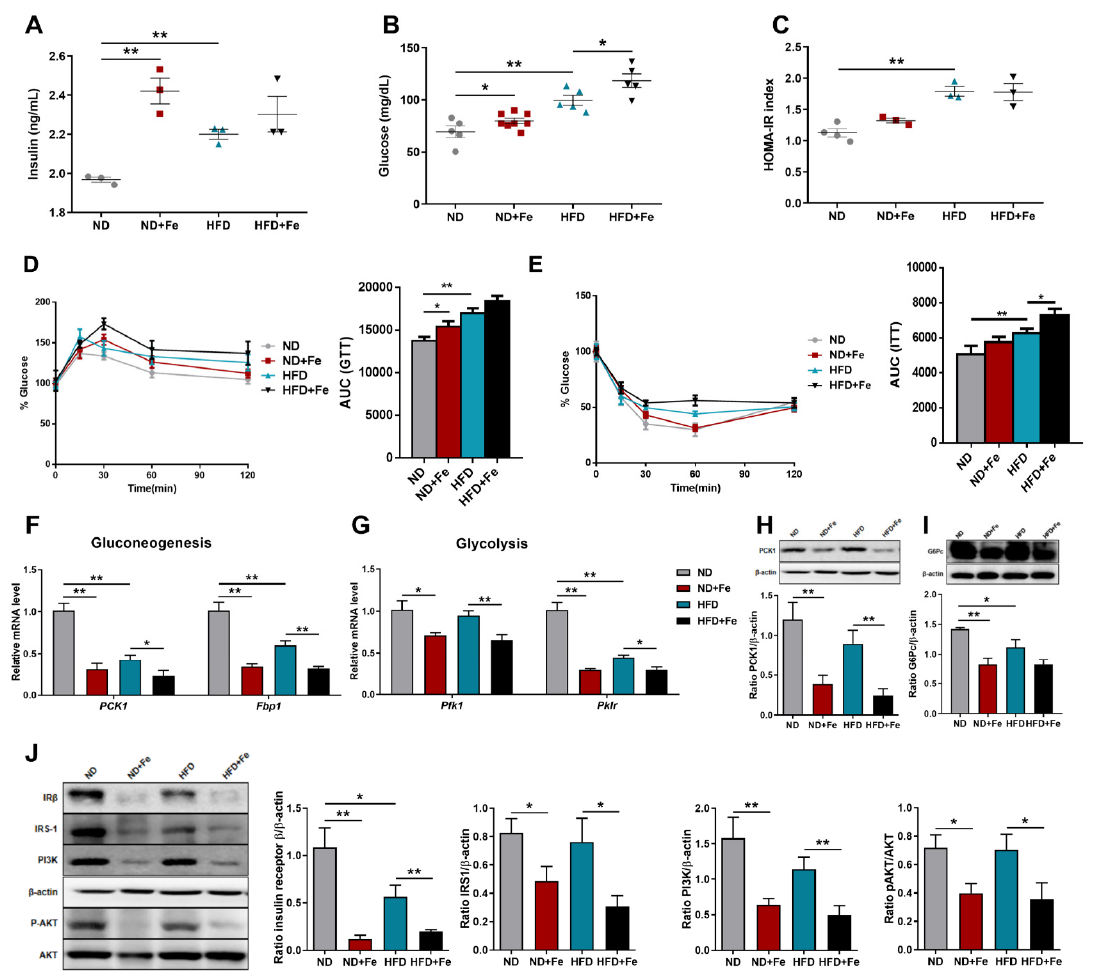
Figure 4. Deleterious insulin sensitivity in iron-overloaded mice. ( A ) Fasting insulin concentration in the serum; ( B ) Fasting blood glucose concentration; ( C ) HOMA-IR index; ( D ) Glucose tolerance test after fasting overnight; ( E ) Insulin tolerance test after fasting overnight. AUC, area under curve; ( F ) Relative expression levels of genes related to gluconeogenesis (PCK1, Fbp1) in the liver; ( G ) Relative expression levels of genes involved in glycolysis (Pfk1, Pklr) in the liver; ( H , I ) Western blot analysis of PCK1 and G6Pc protein expression and its quantification in liver samples; ( J ) Western blot analysis of IR β , IRS-1, PI3K, p-AKT and total AKT protein expression and their quantification in liver samples. ND ( n = 6), ND + Fe ( n = 7), HFD ( n = 7), and HFD + Fe ( n = 8). The values are the means ± SEMs. * p < 0.05, ** p < 0.01. Significant differences between two groups were analyzed with the two-tailed Student’s t test.